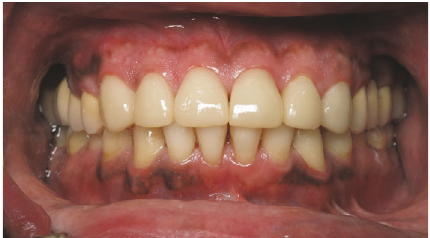
Figure 9: Final prosthesis with improved esthetics and anterior guidance.